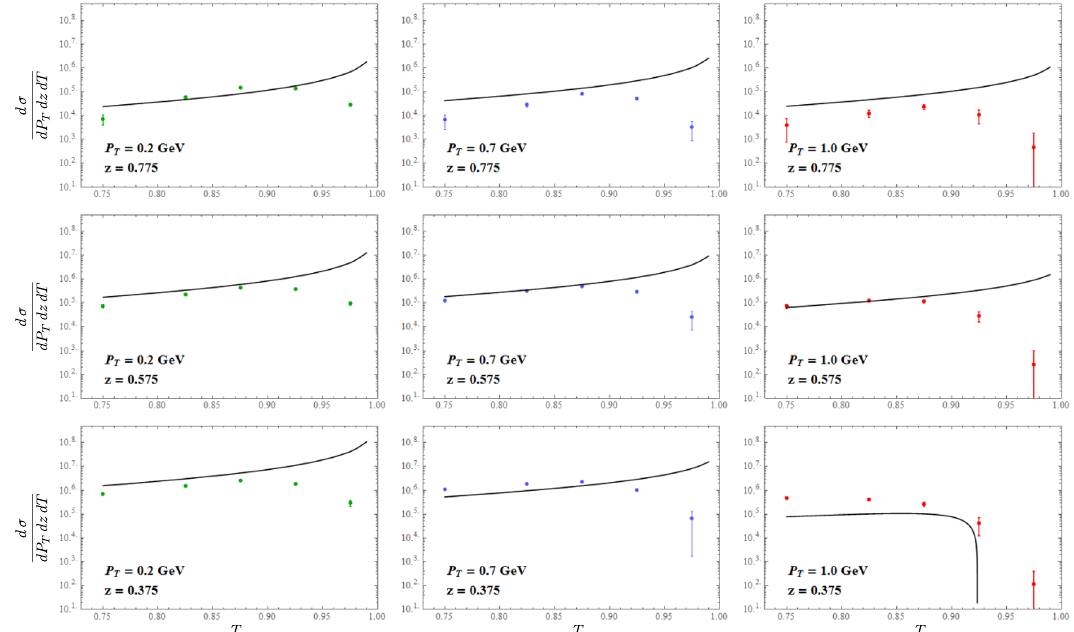
JHEP02(2021)076 Figure 8 . e + e − → hX cross section computed to NLO and NLL accuracy plotted as a function of thrust, T , in three z -bins and three (representative) P -bins, as indicated in the plot legends. T In the upper row of panels z = 0 . 775 , in the central row z = 0 . 575 and in the lower row of panels z = 0 . 375 . Uncertainty bands are not shown as no fit is involved in this computation. The collinear fragmentation functions used for the implementation of eq. (4.5) are the NNFF10_NLO reference set for π + production [38].Uncertainties due to the errors on the collinear fragmentation functions are not